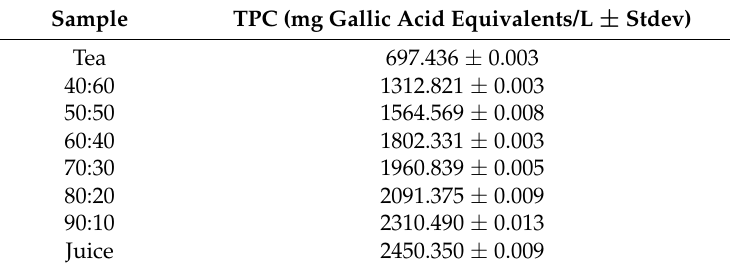
Table 3. Total Phenolic Content (TPC) in the PJ and GT